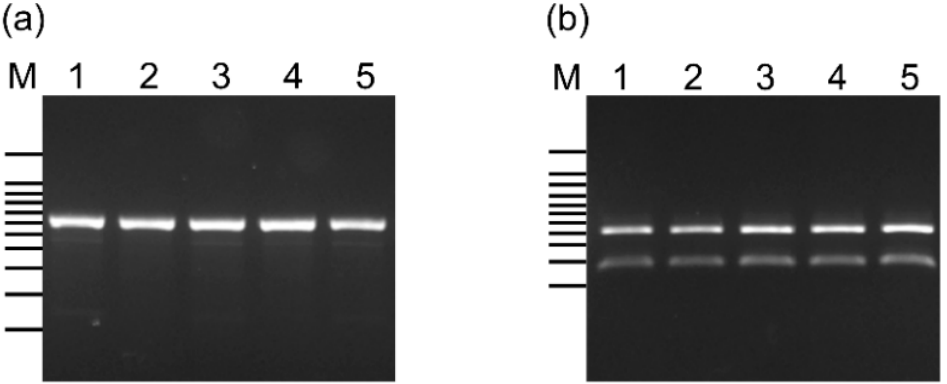
Figure 2. PCR amplification ( a ) and digestion with AseI ( b ) of the Lactococcus lactis subsp. lactis gadB gene. Lane M shows the 100-bp ladder marker from 100 to 1000 bp and 1500 bp and lanes 1–5 represent the CBW1, CBW2, CBW3, CBW4, and CBW5 strains,